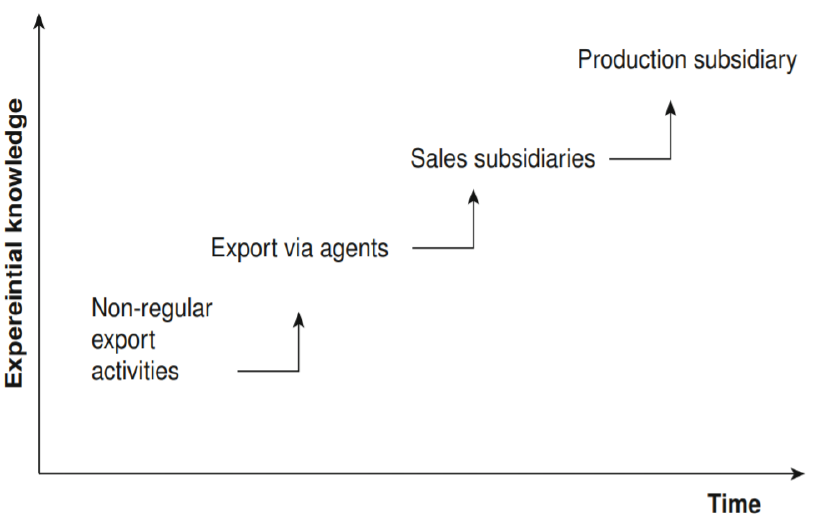
Figure 1. Mechanism of Internationalization. Source: Zucchella and Magnani (2016, p. 49).